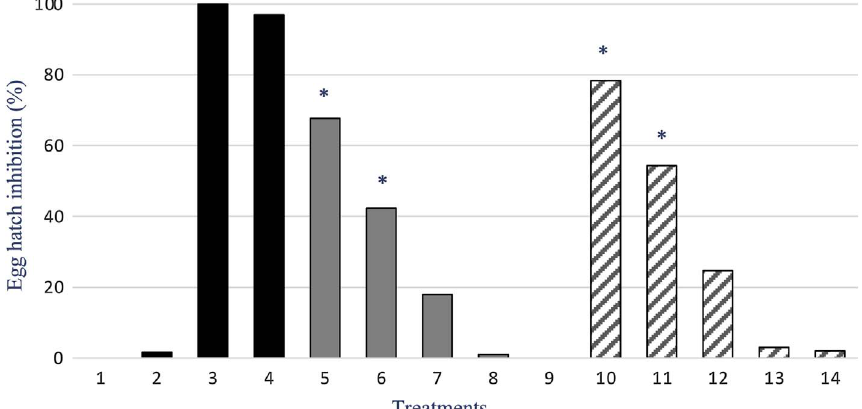
Figure 1. Percentage (%) of gastrointestinal strongyle egg hatch inhibition by fi ve concentrations of Glycyrrhiza glabra root aqueous extract and of glycyrrhetinic acid. Columns: 1: Untreated, 2: DMSO, 3: Thiabendazole, 4: Thiabendazole plus DMSO, 5: 30 mg/mL, 6: 10 mg/mL, 7: 5 mg/mL, 8: 1 mg/mL, 9: 0.5 mg/mL of G. glabra , and 10: 30 mg/mL, 11: 10 mg/mL, 12: 5 mg/mL, 13: 1 mg/mL, 14: 0.5 mg/mL of glycyrrhetinic